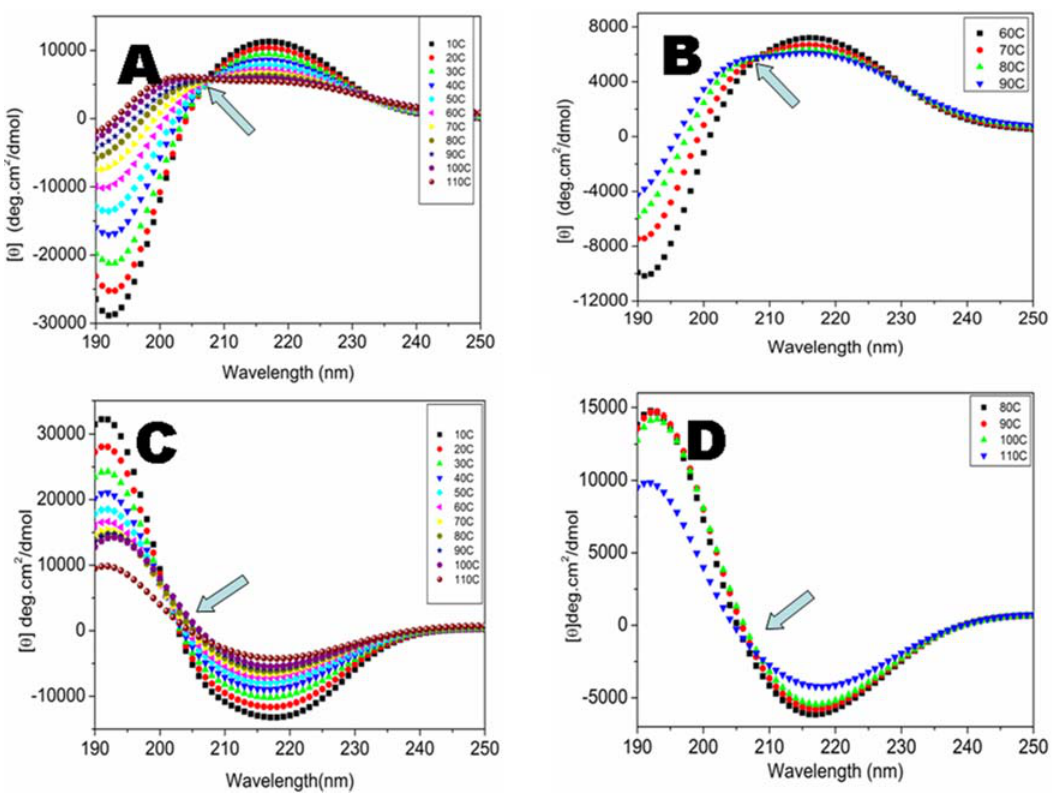
Figure 3. The temperature effect on the d-EAK16 and l-EAK16 (100 m M). Each spectrum was collected at indicated temperature from 10 u C to 110 u C, using the same samples covered with mineral oils to prevent water evaporation. Every temperature point was averaged from 3 measurements. The sample was incubated at indicated temperatures for 15 minutes because 3 at 5-minute each measurements took 15 minutes. After measurement at 10 u C, then the temperature was increased to 20 u C, 30 u C, 40 u C, etc in the CD instrument to reach the indicated temperature and eventually elevated to 110 u C. A) The CD spectra of d-EAK16 from 10 u C to 110 u C. At 20 u C, it formed a stable beta-sheet. This beta-sheet structure was stable until 80 u C. It then underwent two distinctive transitions. During the first transition, the beta-sheet content was not only reduced, but also changed its twist. The second structural transition occurs between 80 u C to 90 u C and drastically between 90 u C to 110 u C. Here, the beta-sheet structure is converted to an alpha-helical structure. B) d-EAK16 exhibits 3 distinctive structures at different temperatures, 60 u C, 80 u C, and 90 u C. The isosbestic point was at 208nm as indicated by an arrow. C) The CD spectra of l-EAK16 from 10 u C to 110 u C. It was a very stable beta-sheet. The beta-sheet content was reduced, but no obvious structural transition was observed. D) l-EAK16 was very stable at different temperatures, 80 u C, 90 u C, 100 u C and 110 u C. No drastic structural transition was observed.